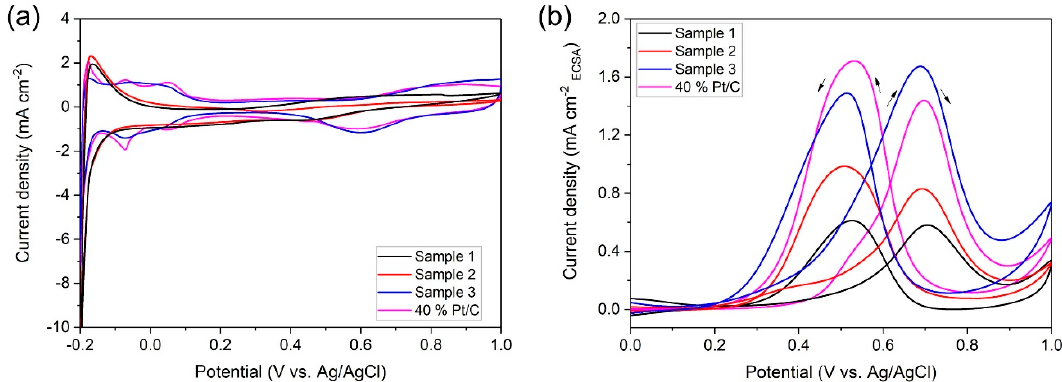
Figure 8. ( a ) CV curves of Pt nanocluster-anchored hollow Ag-Au nanostructures with injected molar ratios of Pt / Au at 3 (black line) and commercialized 40% Pt / C catalysts (red line) recorded in N 2 -saturated 0.5 M H 2 SO 4 solution. ( b ) Electrocatalytic performance of Pt nanocluster-anchored hollow Ag-Au nanostructures with injected molar ratios of Pt / Au at 1 (black line), 2 (red line) 3 (blue line) and commercialized 40% Pt / C catalysts (purple lien) recorded in N 2 -saturated 1 M CH 3 OH + 0.5 M H 2 SO 4 solution.